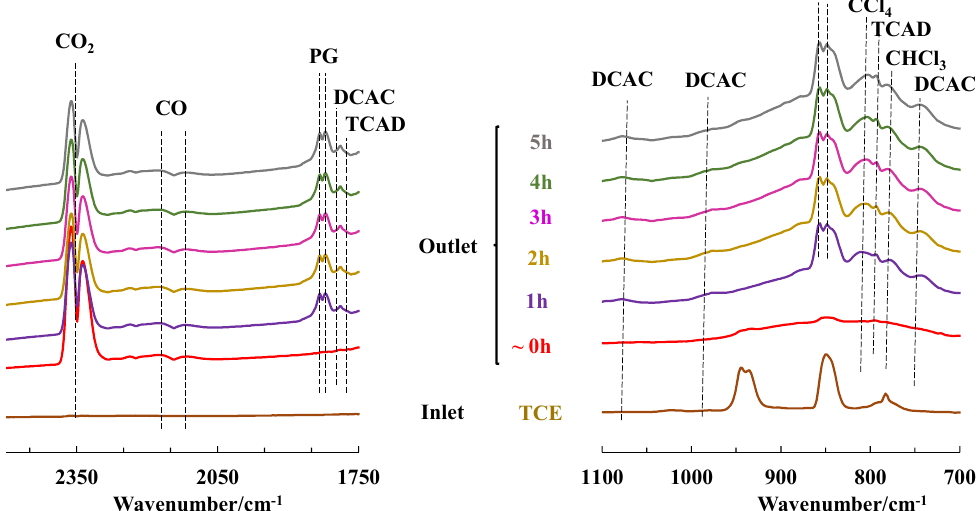
Figure 9. FT-IR spectra of the inlet TCE and outlet gaseous stream after the PPC process (RH = 0.7%) as a function of time with Ce 0.01 Mn-400 as the catalyst. PG: phosgene; DCAC: dichloroacetylchloride; TCAD: trichloroacetaldehyde.